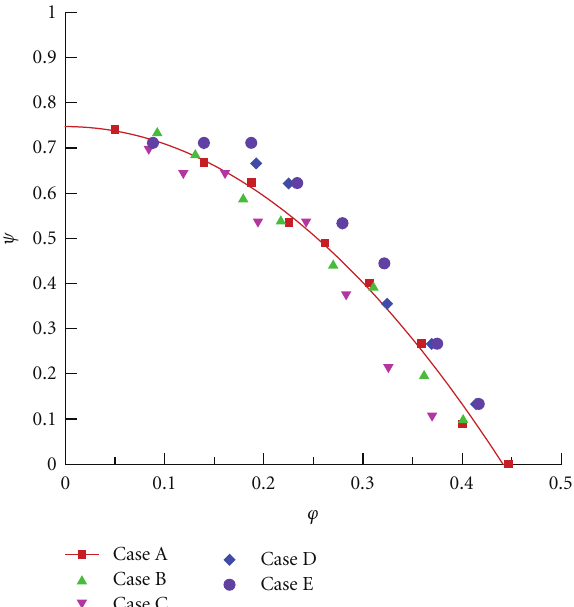
Figure 9: The ψ - ϕ curve of the tested CFF using porous stabilizers.